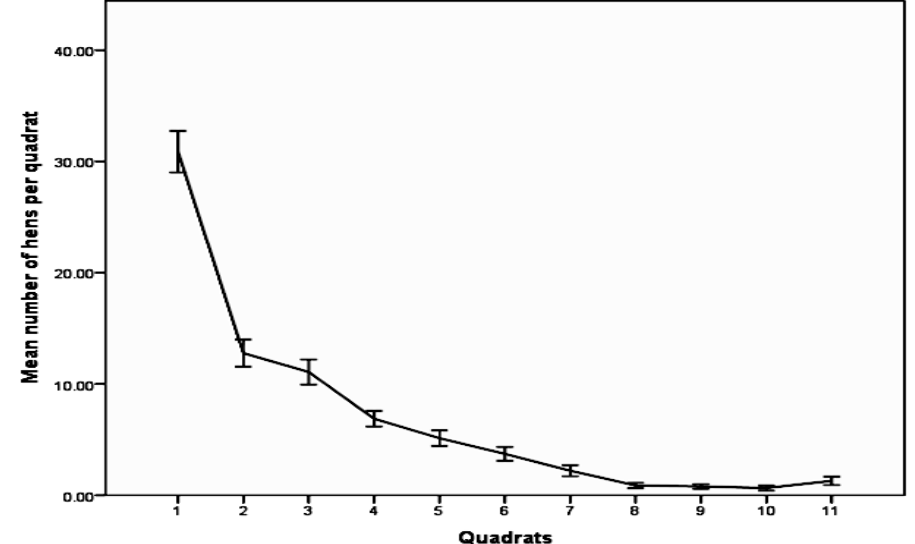
Figure 2. The mean (±SE) number of hens per 100 m 2 quadrat from first quadrat on apron, through enriched belt (2–5) and outer range (6–11) showing sharp decline in numbers with distance from